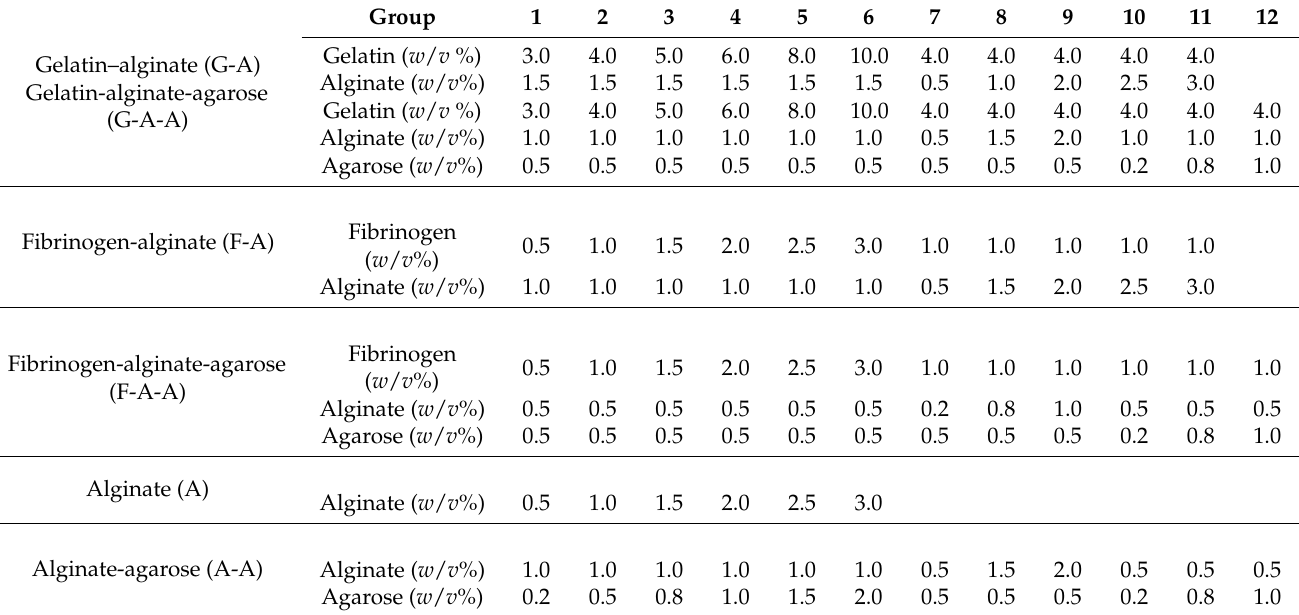
Table 1. Composition and proportion of the alginate-based